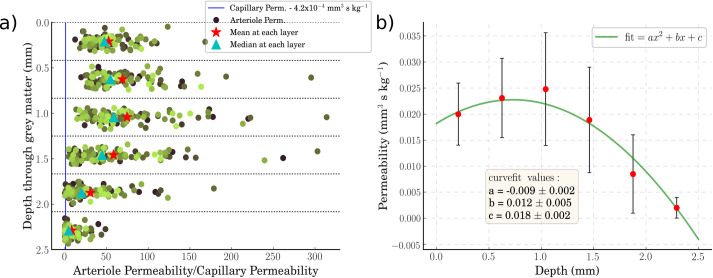
a) A scatter plot of the permeability of the 100 voxels at each of the 6 depth layers. The cyan triangle indicates the median permeability of the capillary bed. The mean arteriolar permeability is indicated with a red star at each layer. The arteriolar permeabilities (circles) are shaded differently to aid visualisation. b) A quadratic line of best fit over the median permeabilities at each layer–error bars are interquartile ranges.